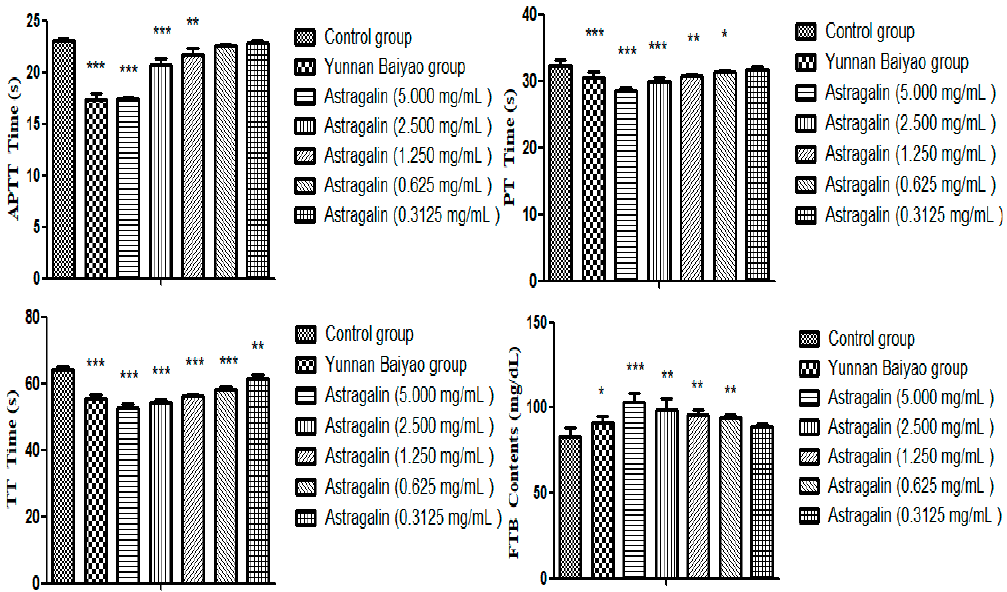
Figure 2. Procoagulant activity of different concentrations of astragalin ( X ± SD, n = 3). Compared with control group: *** p < 0.001, ** p < 0.01, * p < 0.05.